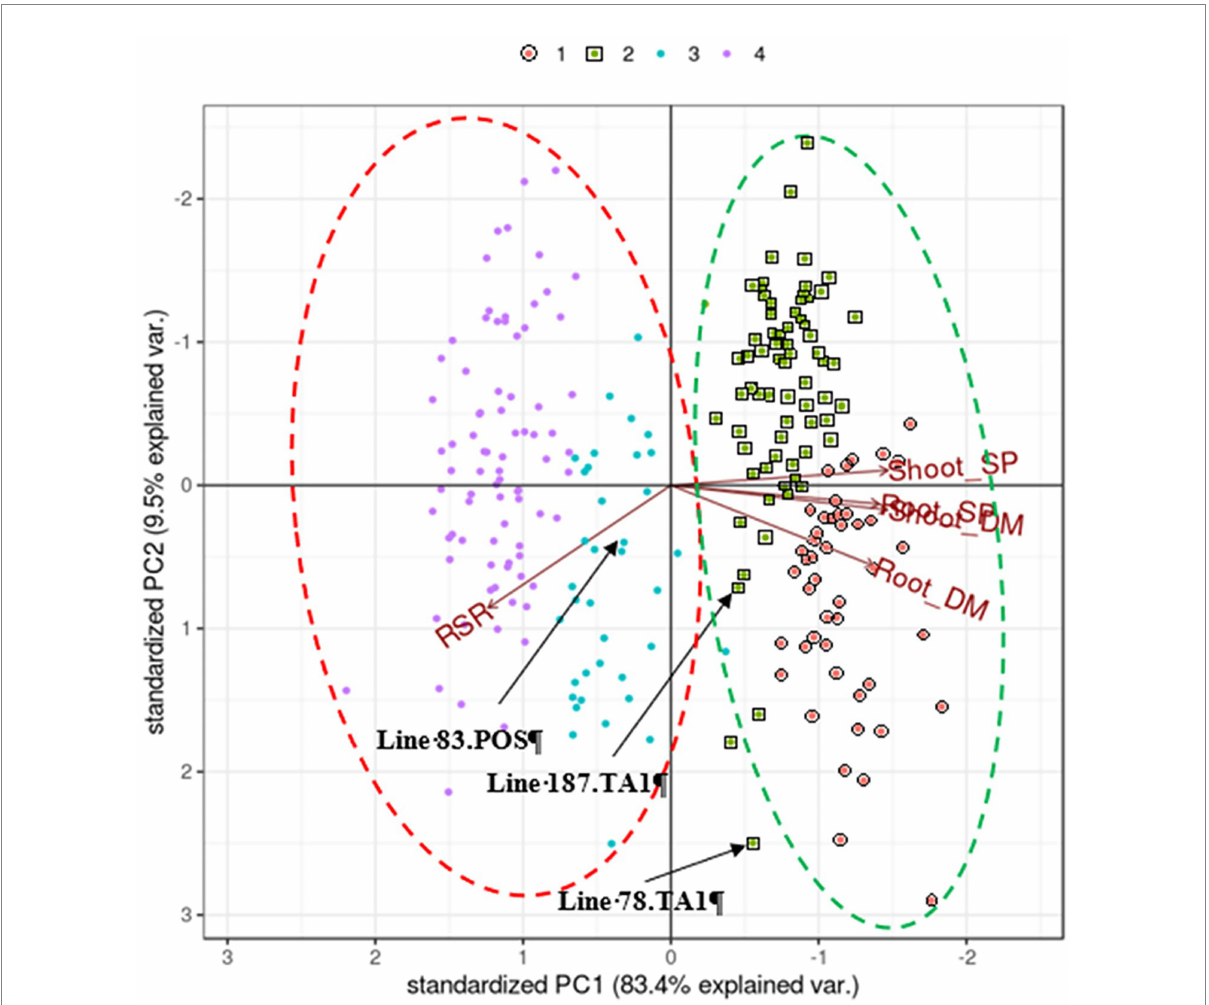
FIGURE 1 Biplot generated by pattern analysis using best linear unbiased predictor (BLUP) adjusted means of 120 white clover half-sib families assessed with two treatments: Rhizobium leguminosarum bv. trifolii strain TA1; and No Rhizobium , nitrogen-supplemented (positive control; POS). Plant responses associated with PCA dimensions 1 and 2 are Shoot DM (dry matter plant − 1 ); Root DM; Shoot SP (symbiotic potential plant − 1 ); Root SP; RSR (root to shoot ratio plant − 1 ). Colours (top of figure) indicate half-sib family membership to pattern analysis Cluster groups (1–4). The coloured dashed circles indicate manually constructed trend lines for treatment clusters; red, indicates TA1 Cluster groups; green, indicates No Rhizobium , nitrogen-supplemented treatment Cluster groups. Half-sib families of interest (eg Line 83.POS) are indicated for discussion in the